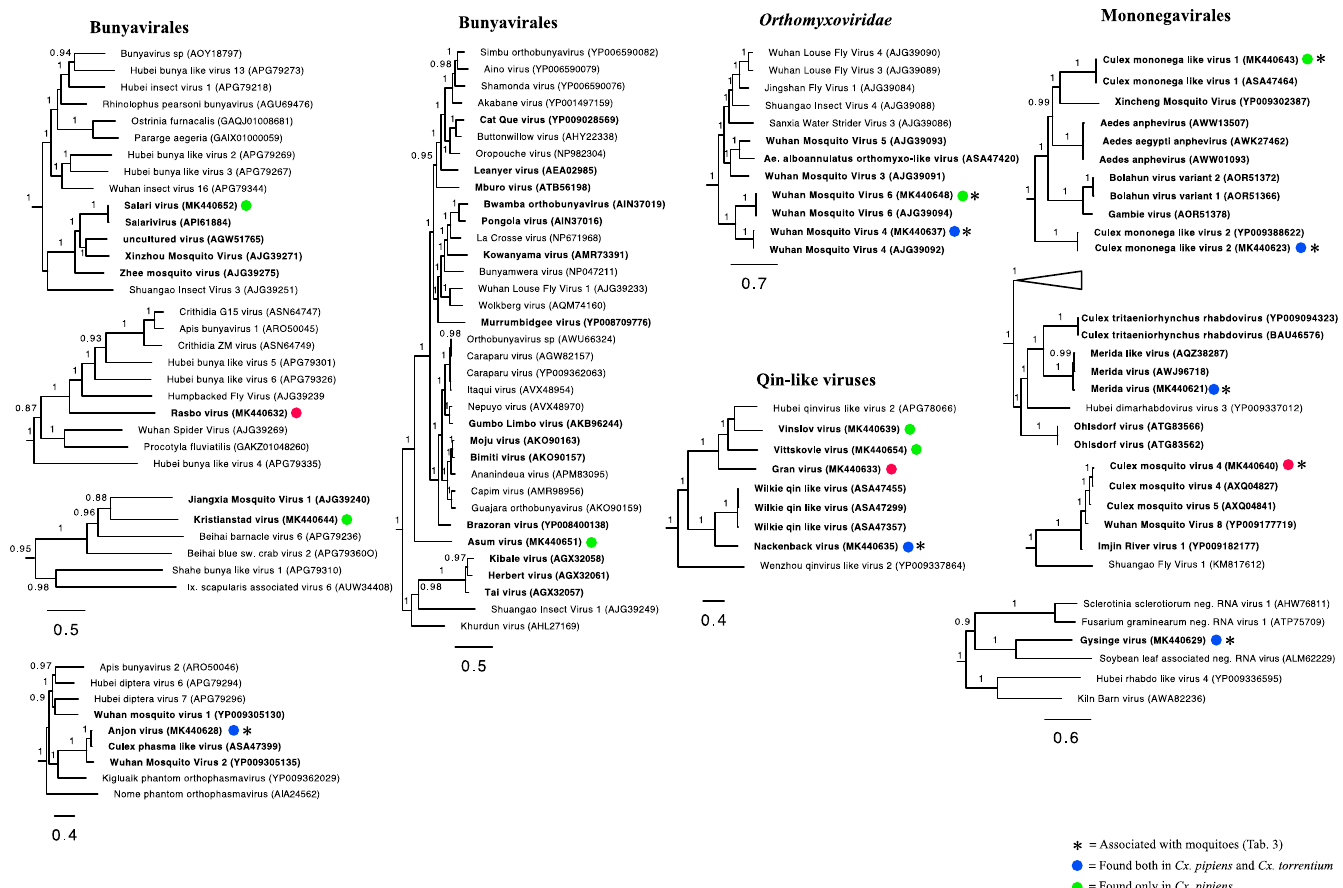
Figure 5. Phylogenetic analysis of all the negative-sense RNA viruses identified here (marked by colored circles) along with representative publicly available viruses. Those viruses most likely associated with mosquitoes are marked by an *. Numbers on branches indicate SH support, and only branches with SH support ≥ 80% are indicated. Branch lengths are scaled according to the number of amino acid substitutions per site. All phylogenetic trees were midpoint-rooted for clarity only. Known mosquito-associated viruses and virus sequences that were derived from mosquito samples are indicated in bold.